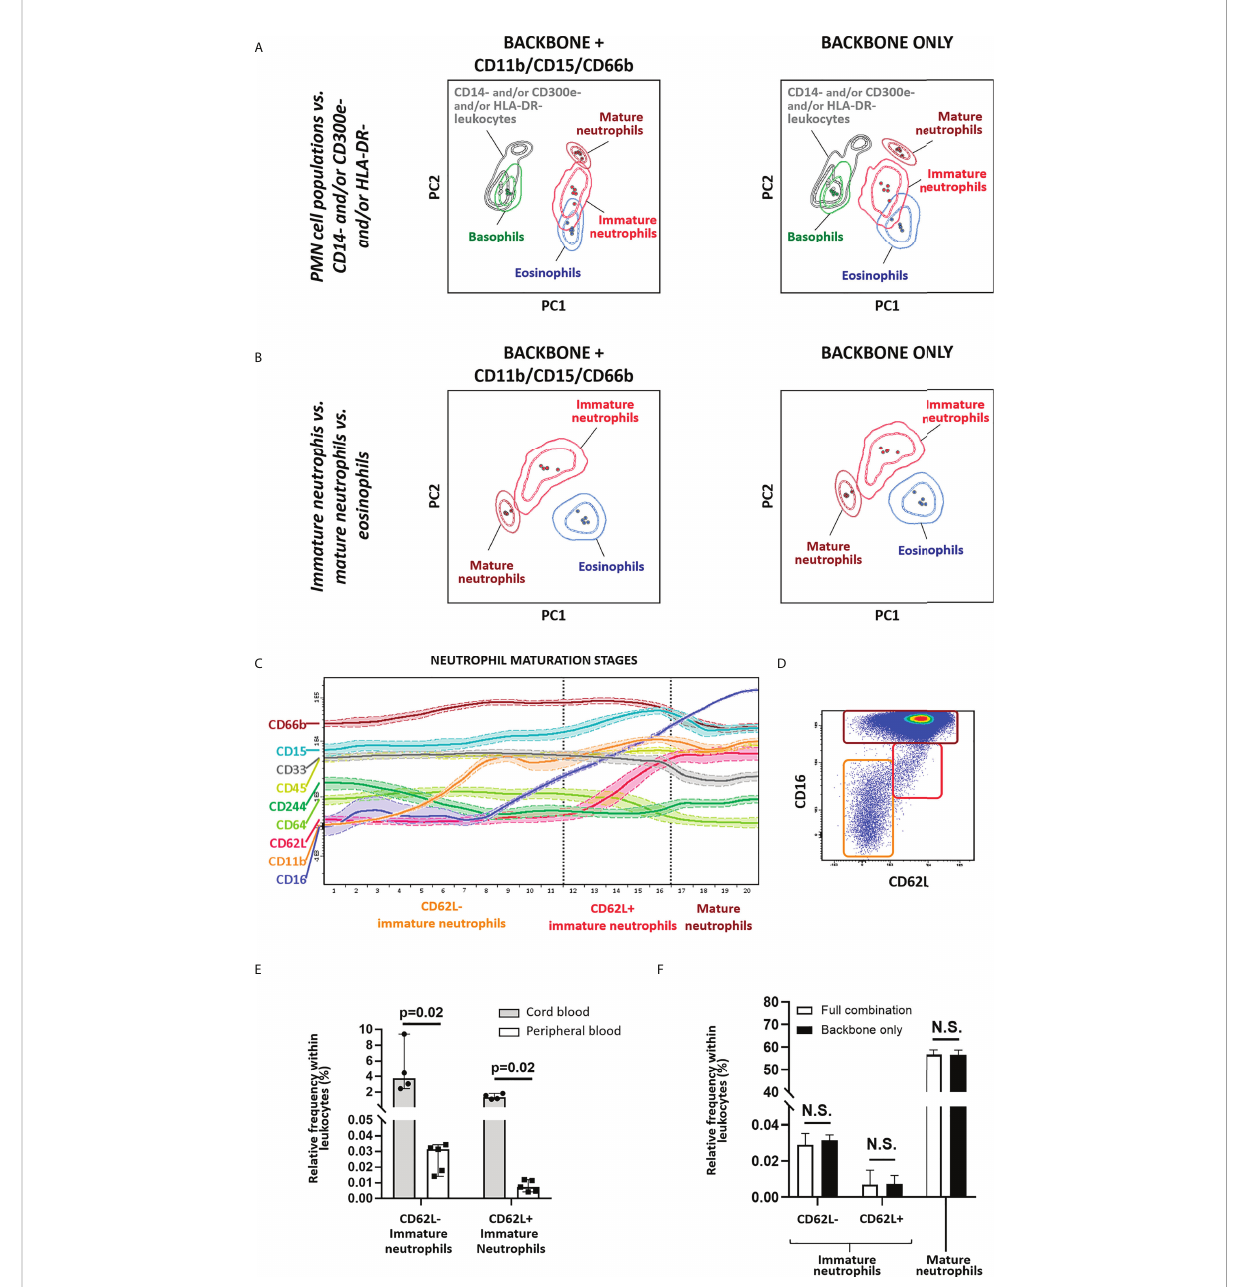
FIGURE 4 Identi fi cation of immature neutrophils. Principal component analysis (PCA) plots depicting the overall performance of backbone markers for general monocytic and dendritic cell identi fi cation (CD14, CD16, CD33, CD45, CD62L, CD300e, HLA-DR) in combination with size (FSC) and internal complexity (SSC) vs. same combination plus CD11b, CD15, CD66b, for identi fi cation of polymorphonuclear (PMN) cell populations (basophils, eosinophils and neutrophils) (A) and for identi fi cation of immature vs. mature neutrophils and eosinophils, within the SSC hi cell compartment (B) . Wanderlust plot exhibiting the modulation of markers related with neutrophil maturation is depicted in (C) , whereas a dot plot depicting the different neutrophil populations identi fi ed employing the backbone markers is shown in (D) . (E) depicts the relative frequency of immature neutrophils in cord blood (CB) (n=4) vs. adult peripheral blood (PB) (n=5), whereas (F) displays the impact on the relative frequency of the populations with inclusion of CD11b, CD15 and CD66b vs. backbone combination only. Statistical differences were evaluated employing Wilcoxon and Mann-Whitney tests, to compare between gating strategies and CB vs. PB, respectively. Solid circles in the PCA plot represent median values for the parameters evaluated, inner dotted and outer solid lines depict the fi rst standard and second standard deviations for each population identi fi ed. Expression in the Wanderlust plot is reported as median fl uorescence intensity (solid line) and one standard deviation (dotted line). Bars on graphs depict the median and 95% con fi dence interval. PMN, polymorphonuclear; PC, principal component. N.S., not statistically signi fi cant (p